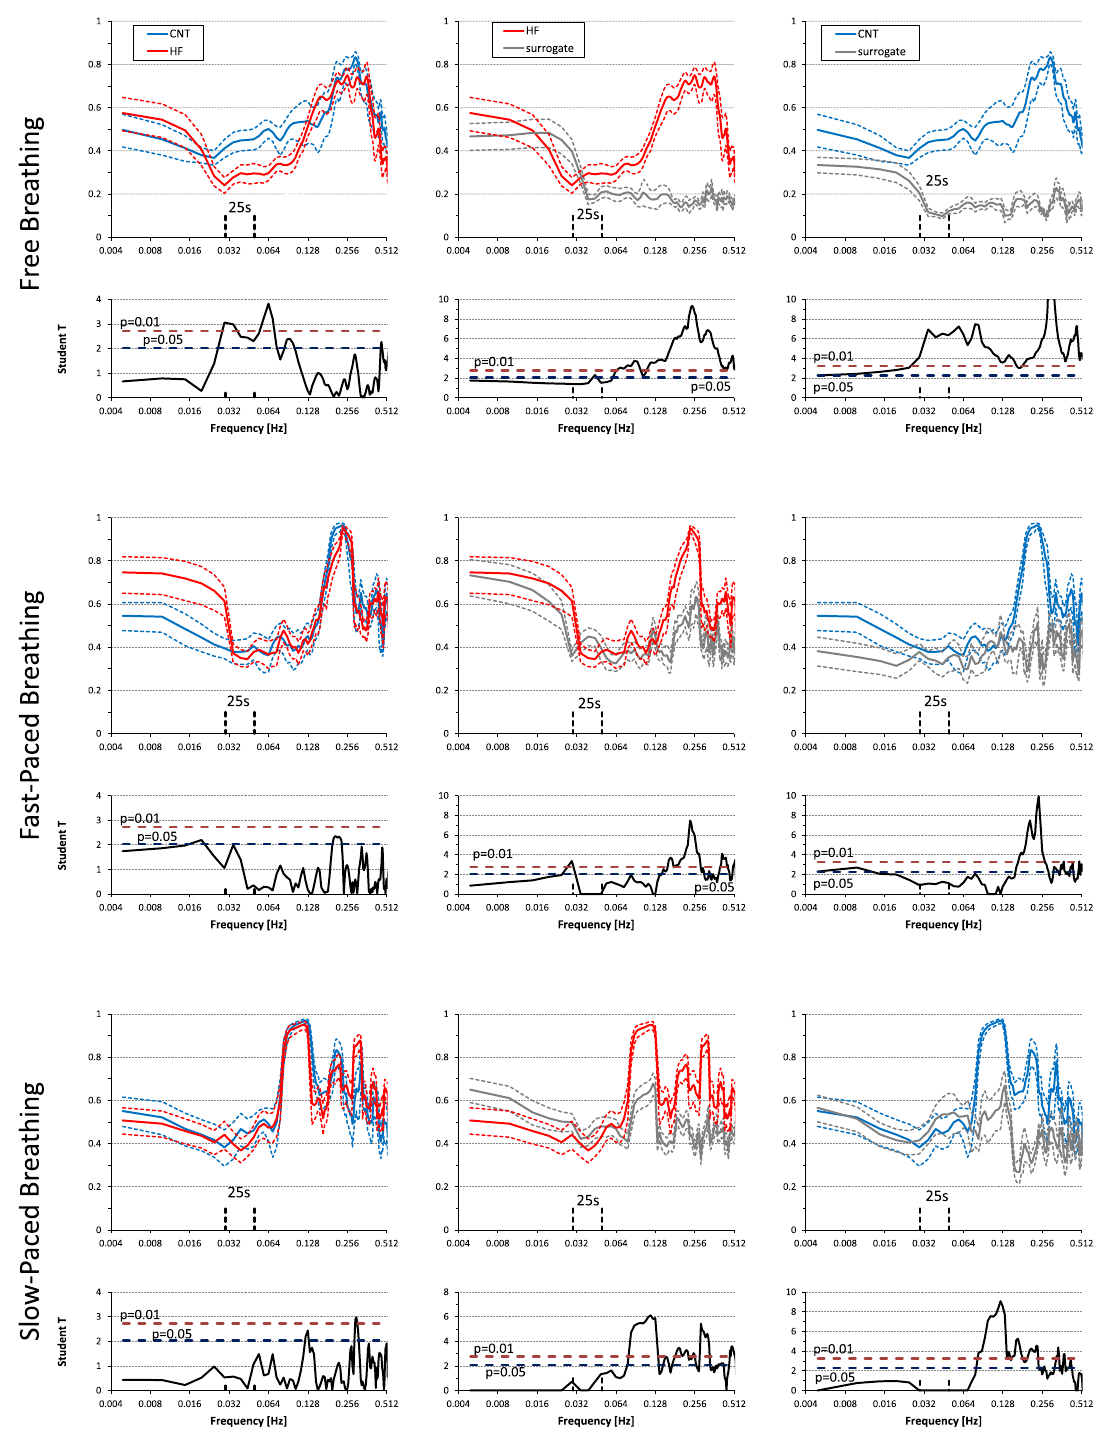
Figure 5. RSP–SBP coherency spectra during free, fast-paced, and slow-paced breathing. Spectra as mean ± sem, with Student T between groups. Left panels compare heart failure (HF) patients and controls (CNT): T-values above the dashed lines point out significant differences between groups. Central panels compare original and surrogate coherency spectra in the HF group while right panels compare original and surrogate coherency spectra in the CNT group: T-values above the dashed lines point out coherences significantly greater than 0. During free breathing, note the significantly greater respiratory-blood pressure coupling around 25 s in the CNT group, and that only in the CNT group, and not in HF patients, the RSP–SBP coherency around 25 s is significantly greater than